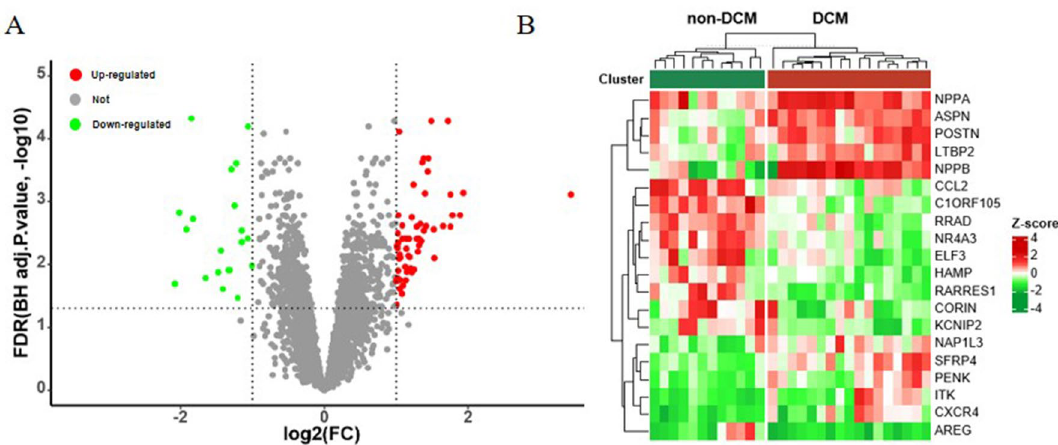
Figure 2. Identification of DEGs in DCM samples. ( A ) The expression volcano plot of the differential gene expression between DCM and non-DCM samples; ( B ) The expression heatmap of the top ten up-regulated and down-regulated DEGs between DCM and non-DCM samples. DEGs: differentially expressed genes; DCM: dilated